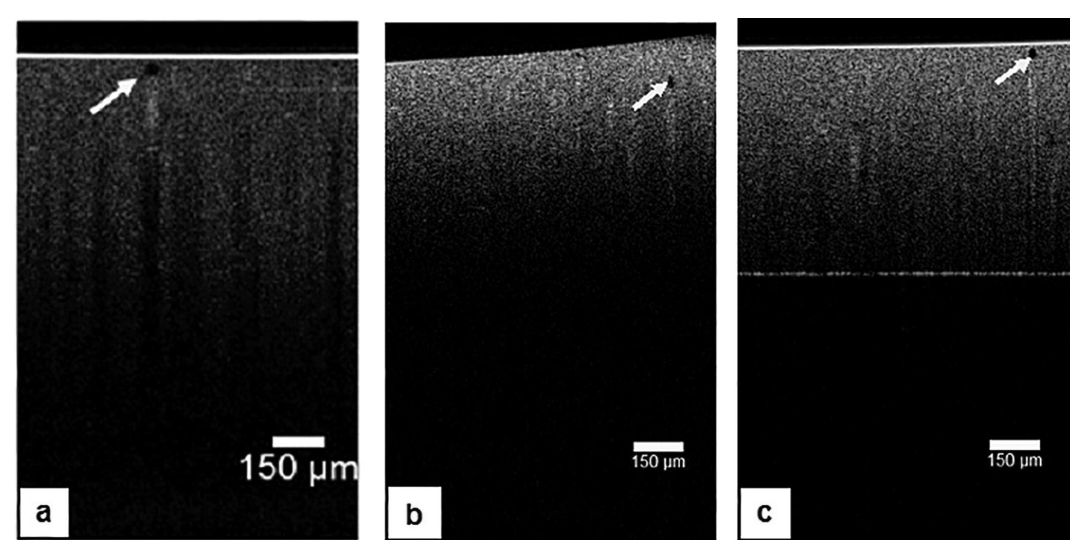
FIGURE 4 - Tomographic images of the emulsified systems (1:10 dispersion in purified water); where (a) ES-1, (b) ES-2 and (c) ES-3. The arrows indicate possible droplets of the emulsion’s inner phase.